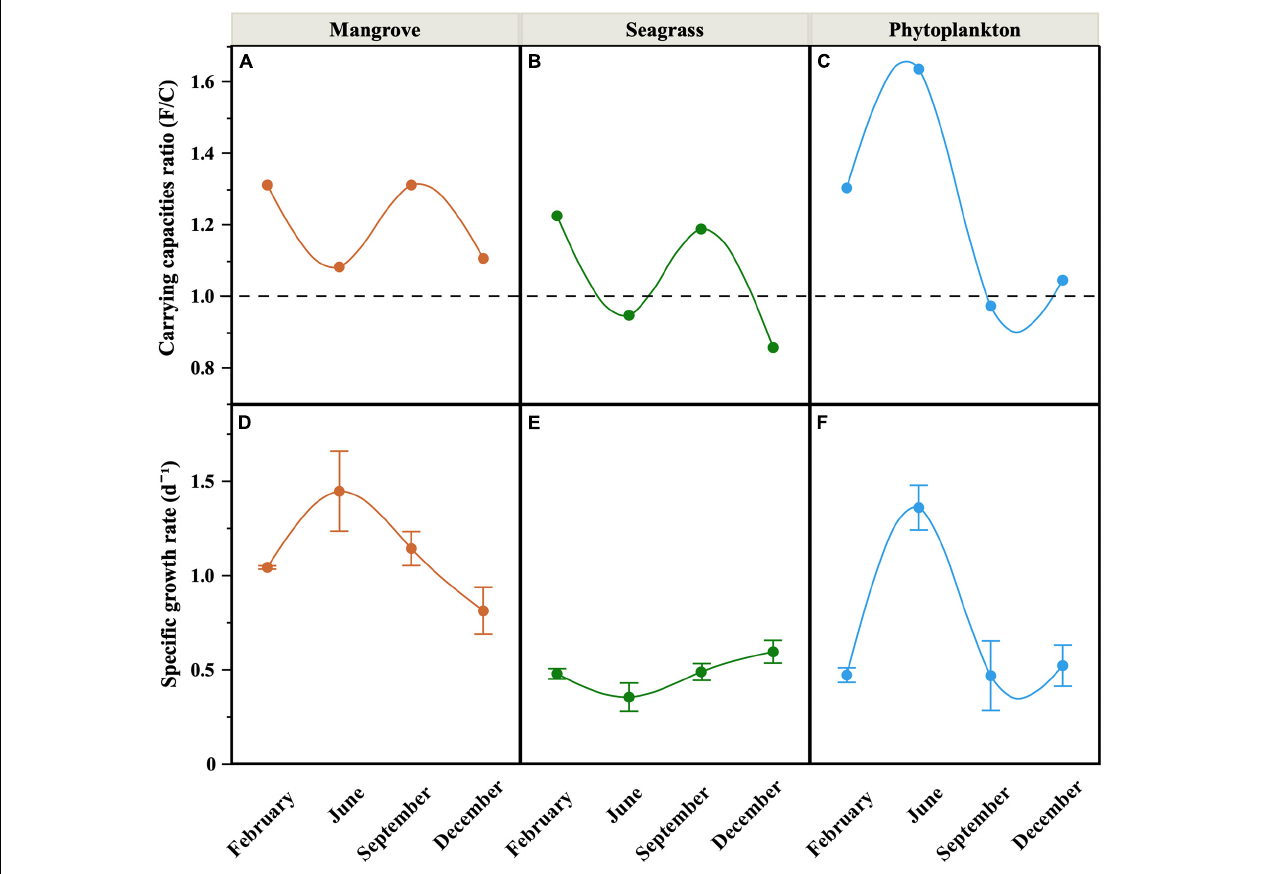
FIGURE 5 | Seasonal distribution of the ratio between the carrying capacities of the Filtered and the Community treatments (A–C) and mean ( ± SE) specific growth rates of heterotrophic bacteria in the Filtered treatment (D–F) at the three sites. Smooth fitting joins site points for clarity. Dashed line in (A–C) represents the 1 value (i.e., no difference between the maximum bacterial abundances of both